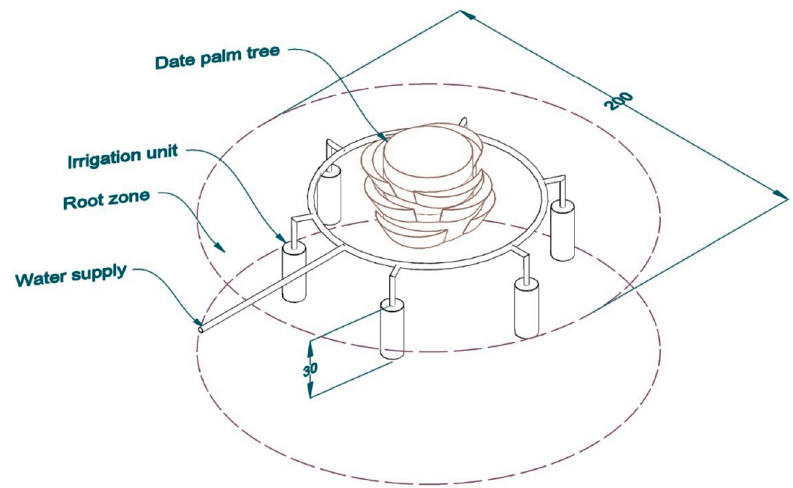
Figure 3. The six subsurface irrigation units distributed equally around the date palm tree in the target irrigation area with a diameter of 200 cm.